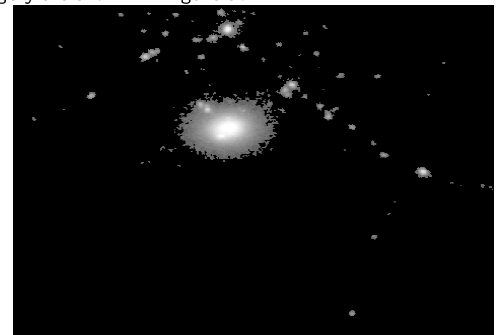
Figure 3. Oil and gas wells in the nighttime light imagery